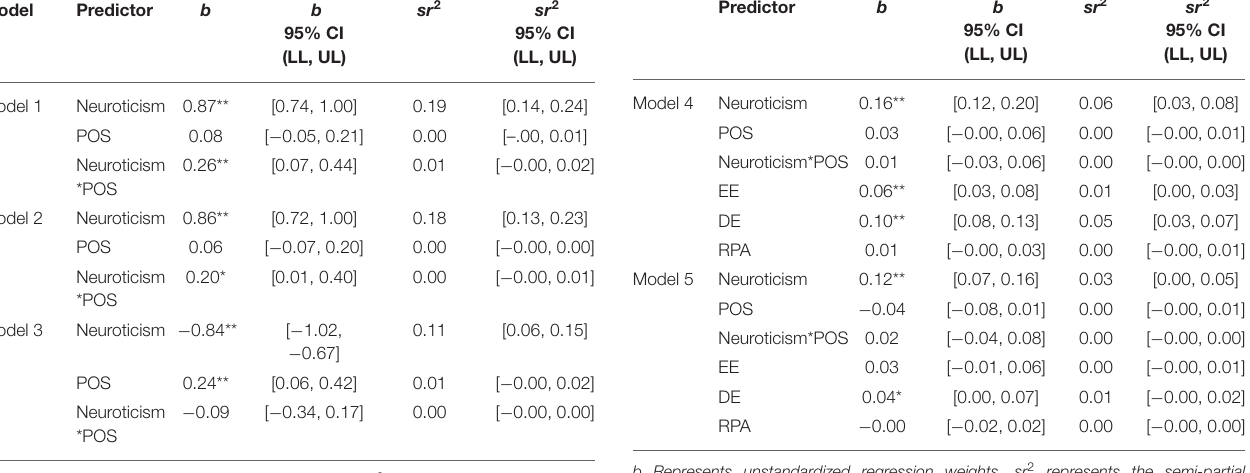
TABLE 2 | Regression results using EE (Model 1), DE (Model 2), and RPA (Model 3) as the criterion. Model